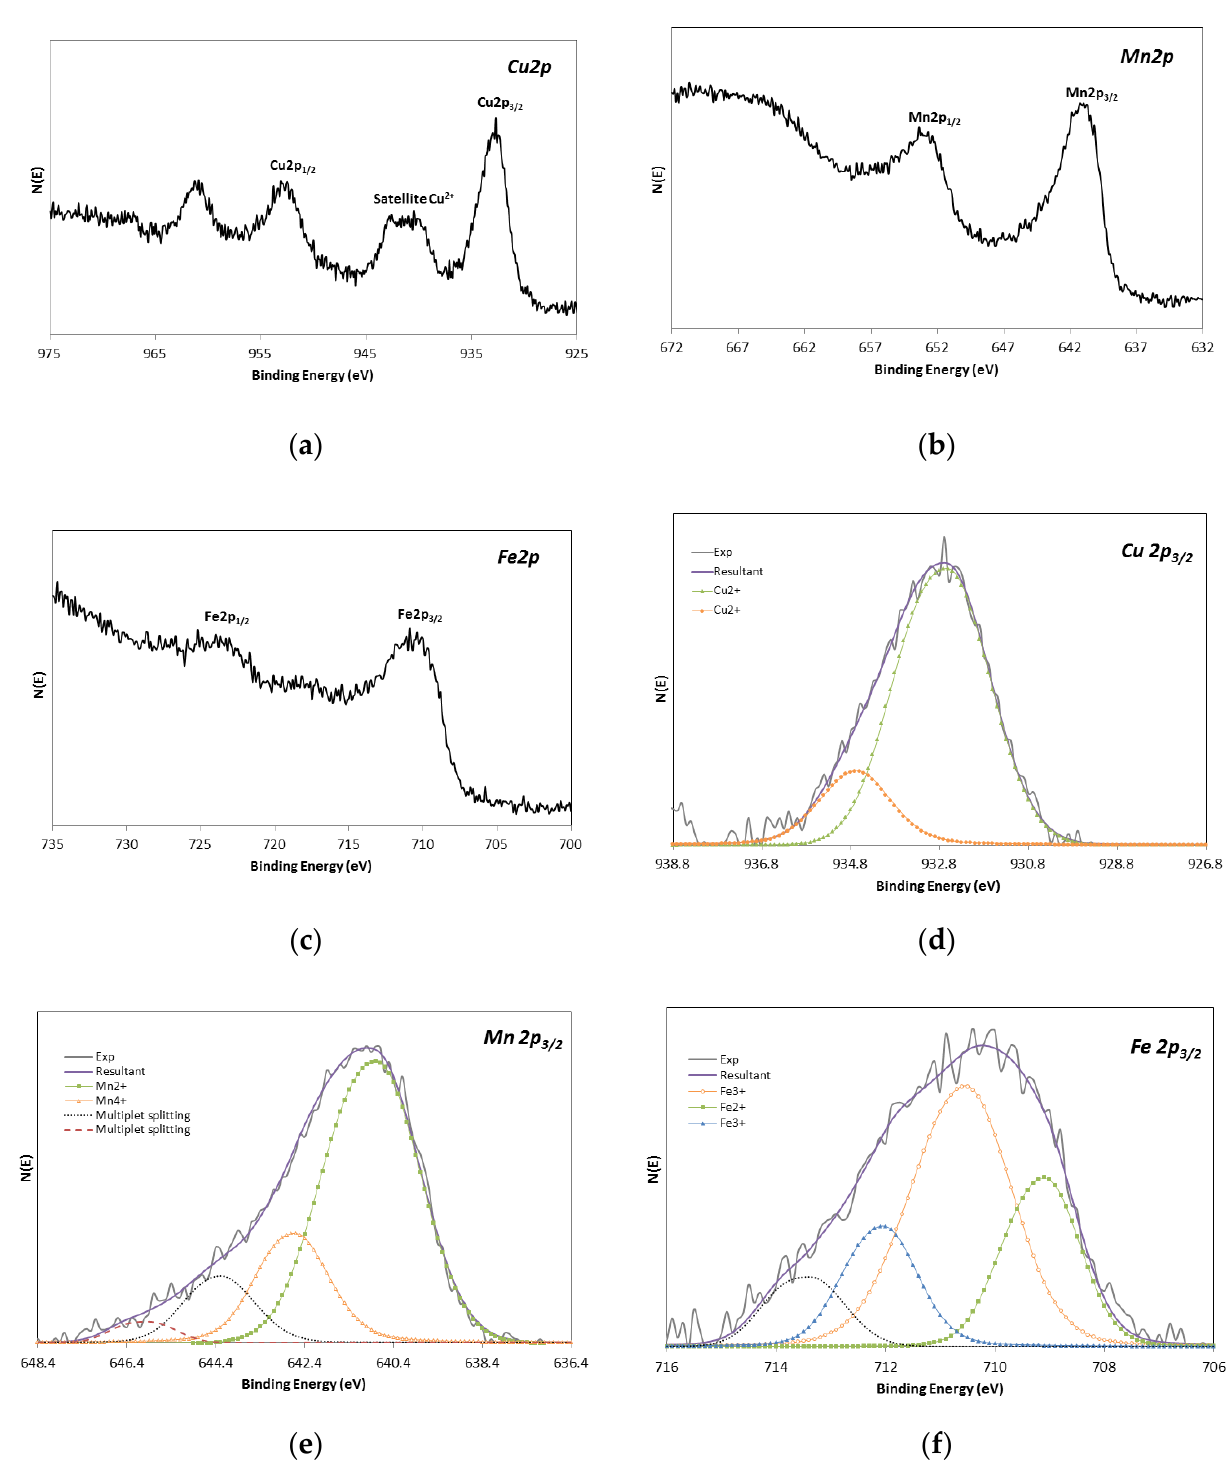
Figure 3. XPS spectra of Cu 2p ( a ), Mn 2p ( b ), Fe 2p ( c ) and the corresponding fit curves of Cu 2p 3/2 ( d ), Mn 2p 3/2 ( e ) and Fe 2p 3/2 ( f ) peaks for CuFeMnO x film annealed at 600 °C. In ( e , f ) the percentages of Mn and Fe species were recalculated once the multiplet split components (higher than 644 eV (Mn)) and satellite contributions (at 713.4 eV (Fe)) were removed. The data related to the oxidation-state percentage and site distribution of copper, manganese and iron ions in CuFeMnO x thin film are summarised in Table